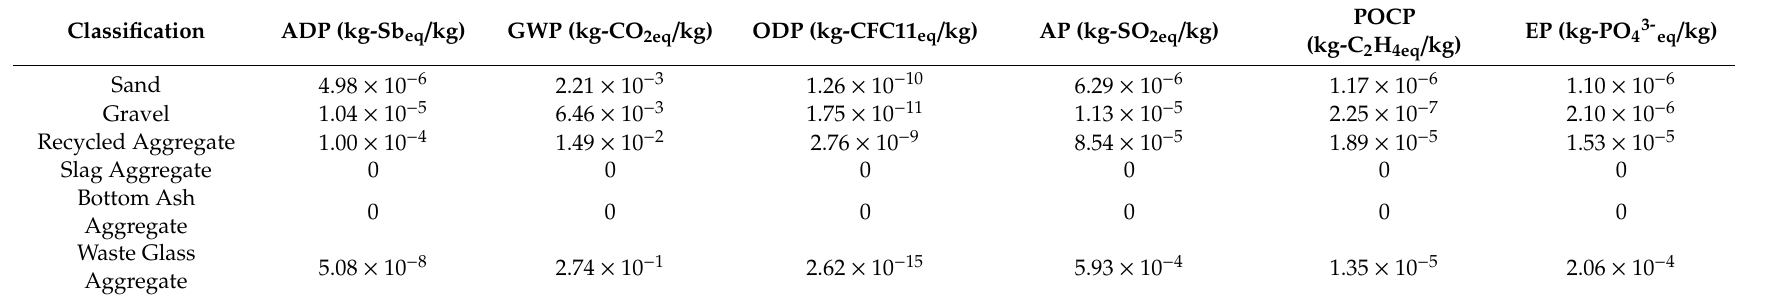
Table 6. Six Environmental Impacts Associated with Each